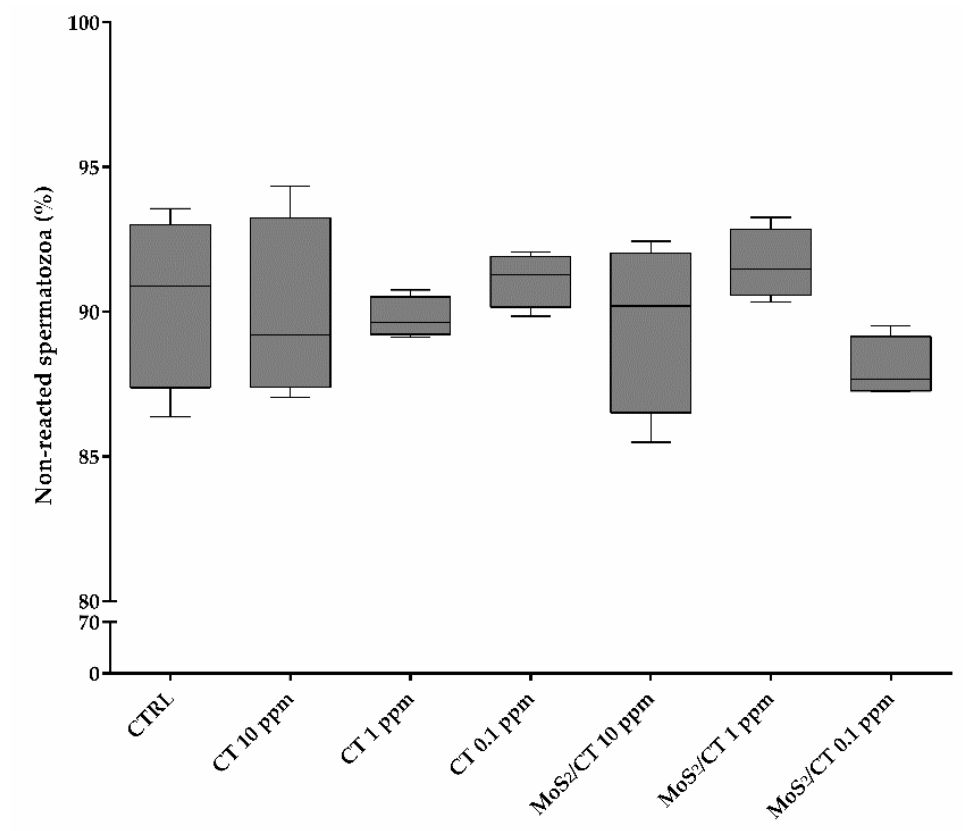
Figure 2. Acrosome integrity. The graph shows the percentage of non-reacted spermatozoa after 1.5 h of capacitation for the different experimental groups: CTRL, CT 10 ppm, CT 1 ppm, CT 0.1, MoS 2 /CT 10 ppm, MoS 2 /CT 1 ppm and MoS 2 /CT 0.1 ppm. A normal acrosome damage rate was obtained, similar to the control (CTRL) group ( p > 0.05). Three independent technical and biological (from different boars) replicates were performed.